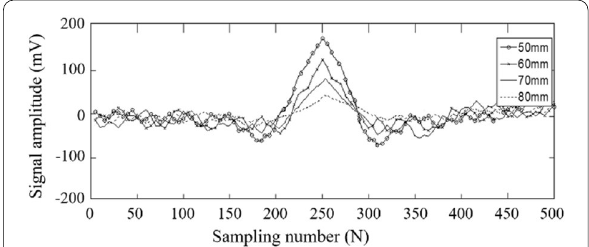
Figure 20 The normal components of the MFL generated by inner defects with buried depths (Sensor scanning above surface 2 indicated in Figure